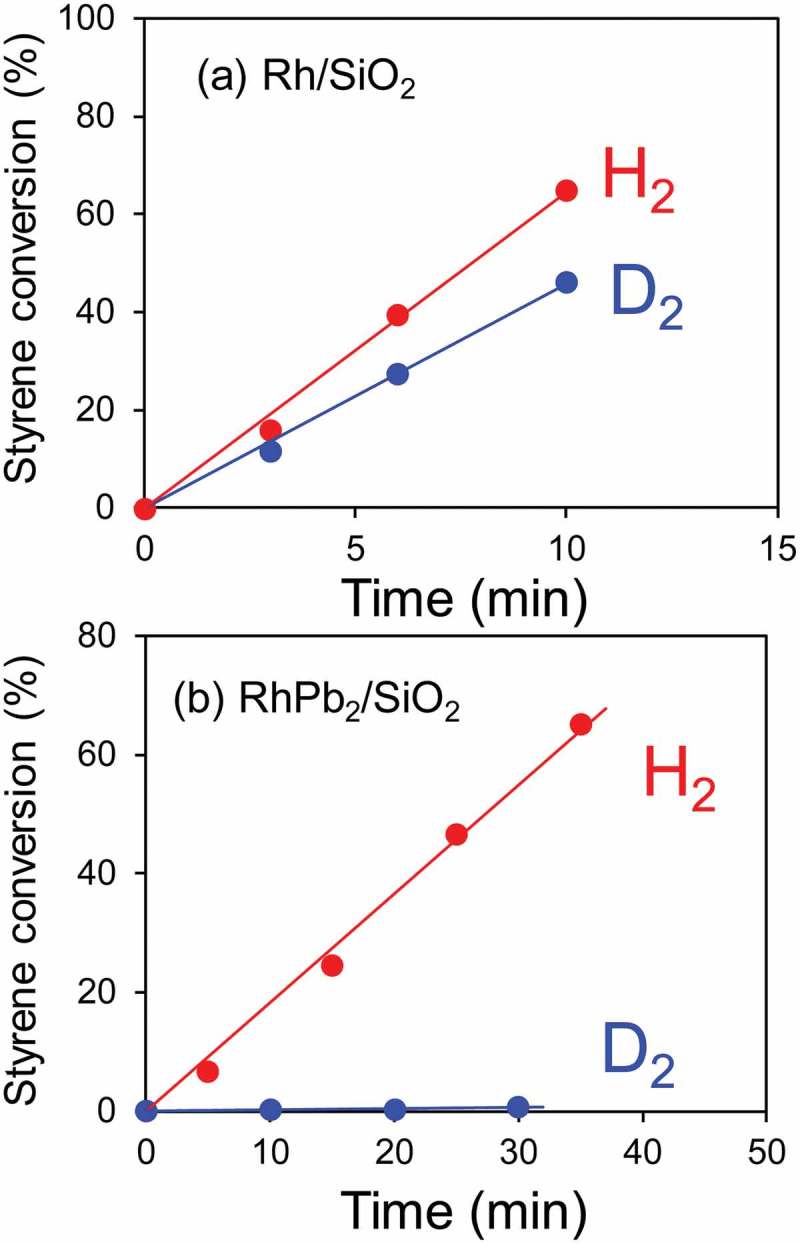
Time-course of ethylbenzene yield in styrene hydrogenation over (a) Rh/SiO2 and (b) RhPb2/SiO2 catalysts when H2 (red) or D2 (blue) was used as a hydrogen source.